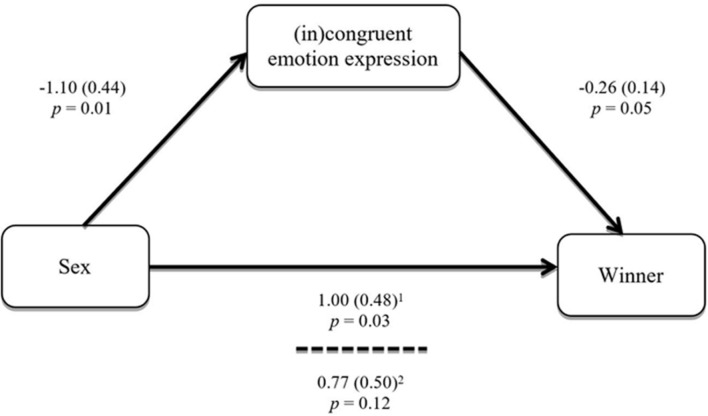
Mediation analysis – study 2. Statistics – coefficient (SE), p-value. Coding – Sex: 1 = female, 0 = male; Facial Emotion Expression:-6 = maximum incongruency, +6 = maximum congruency; Winner: 1 = player; 0 = observer. Normal theory test is not allowed for models with dichotomous outcomes (Preacher and Hayes, 2008). 1Total effect (c path); 2Direct effect (c’ path).